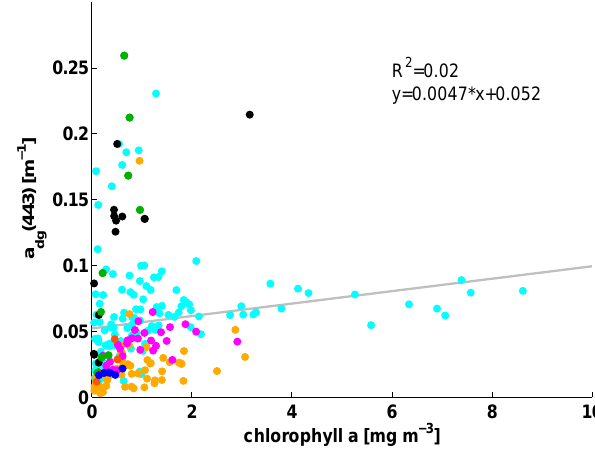
Figure 3. Scatterplot of 244 in situ chlorophyll a concentration and a dg ( 443 ) concurrent measurements from the NOMAD data set used to develop the k d ( bg ) parameterization with CDM, Eq. (5). Color coding corresponds to regional groupings from Fig.